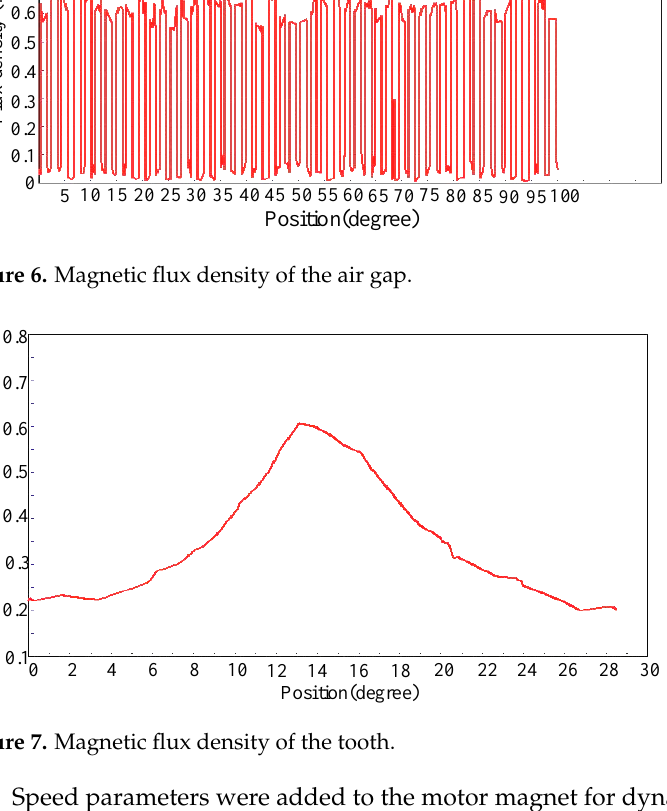
( d ) Figure 8. Magnetic flux density distribution of the motor at different speeds. ( a ) 50 rpm. ( b ) 100 rpm. ( c ) 150 rpm. ( d ) 200 rpm. The two redundant windings had little effect on magnetic field distribution of the motor; now, it is necessary to verify whether they had a great impact on the dynamic